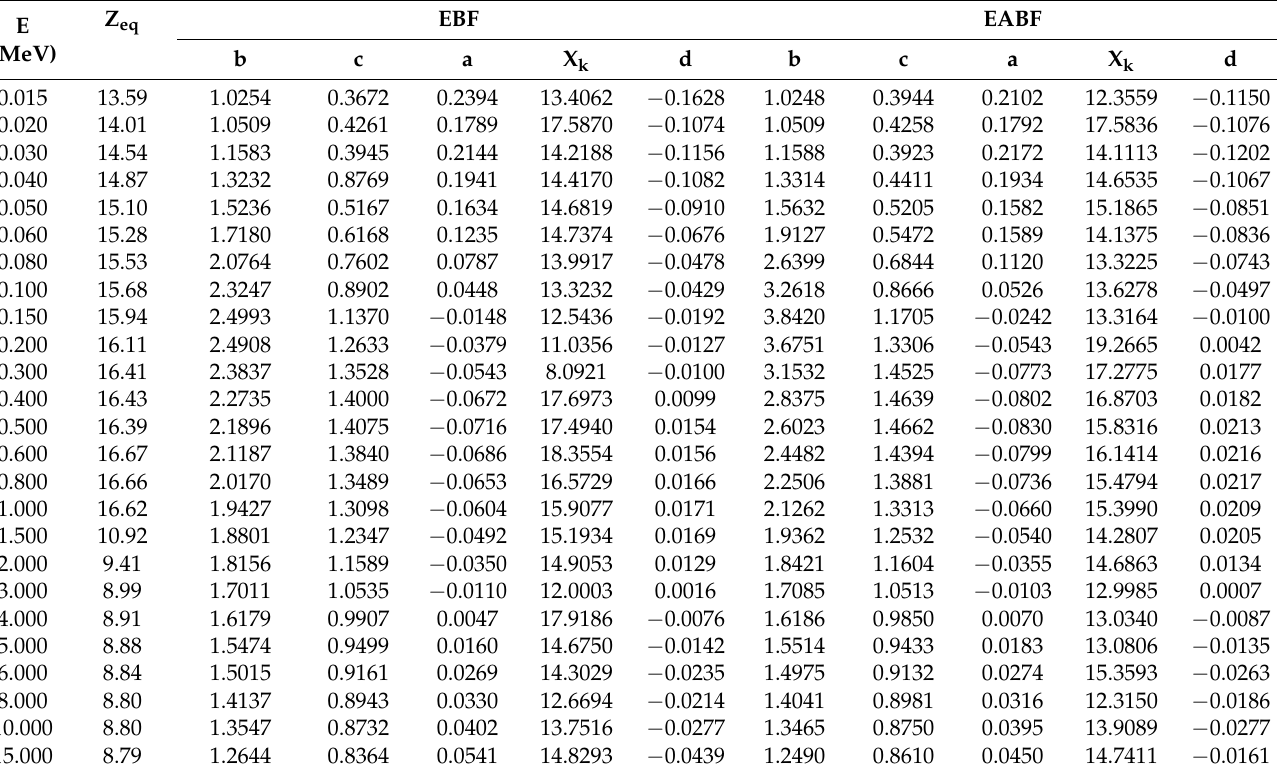
Table 6. (EBF and EABF) G–P fitting coefficients (b. c. a. X k and d) of CuZn15